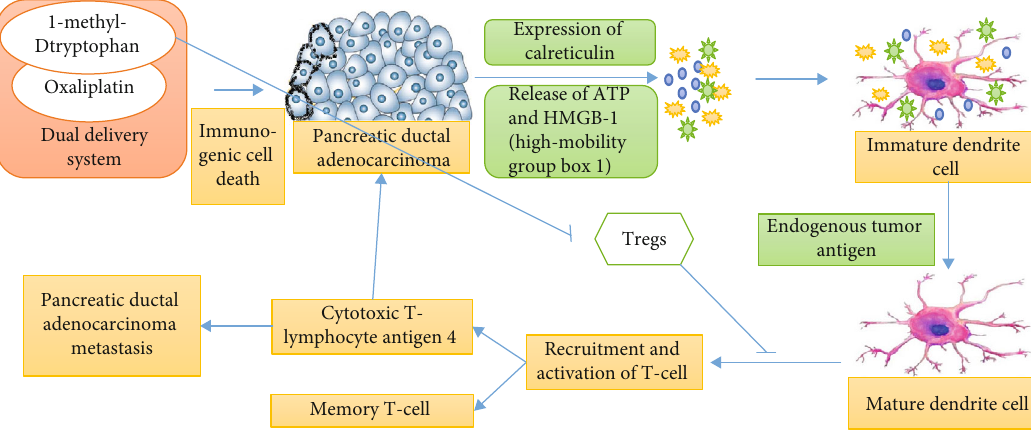
Figure 6: Diagrammatic presentation to express the combined e ff ect of 1-methyl-D-tryptophan and oxaliplatin on immune response in pancreatic ductal adenocarcinoma. A vehicle was prepared for the codelivery of two chemotherapeutics, i.e., 1-methyl-D-tryptophan and oxaliplatin. 1-Methyl-D-tryptophan plays a role in causing immunogenic cell death via expression of calreticulin and release of ATP and HMGB-1 (high-mobility group box 1), while the interference of oxaliplatin with the indoleamine 2,3-dioxygenase 1 pathway is reported. After receiving adjuvant stimuli and uptaking the dying tumor cells, dendrite cells undergo a maturation process along with crosspresentation of tumor antigens. Afterward, primary and metastasized cancer cells are killed by CD+ T cells through granulysin and perforin. This codelivery system in fl uences the indoleamine 2,3-dioxygenase 1 pathway, interferes Treg development, and controls other immunomodulatory activities, resulting in the strengthening of the apoptotic e ff ect by the immune system. The immunogenic cell death pathway involves the activation memory T cells and helper cells which helps in the prevention of disease